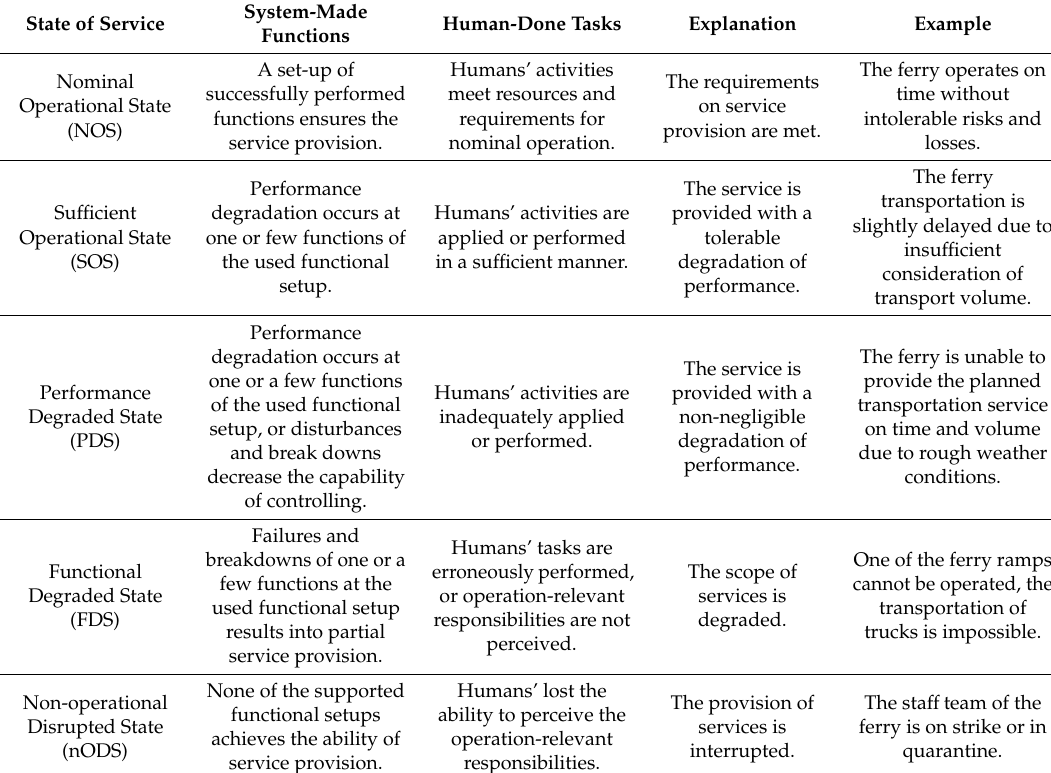
Table 2. States of an extended FSM model specifically focusing on the service provision (using a ferry as